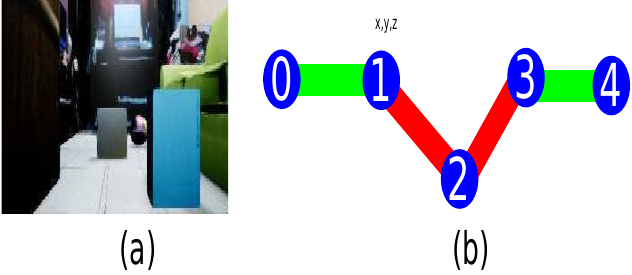
Figure 7. Associated path for each sample. ( a ) Virtual sample. ( b ) Virtual